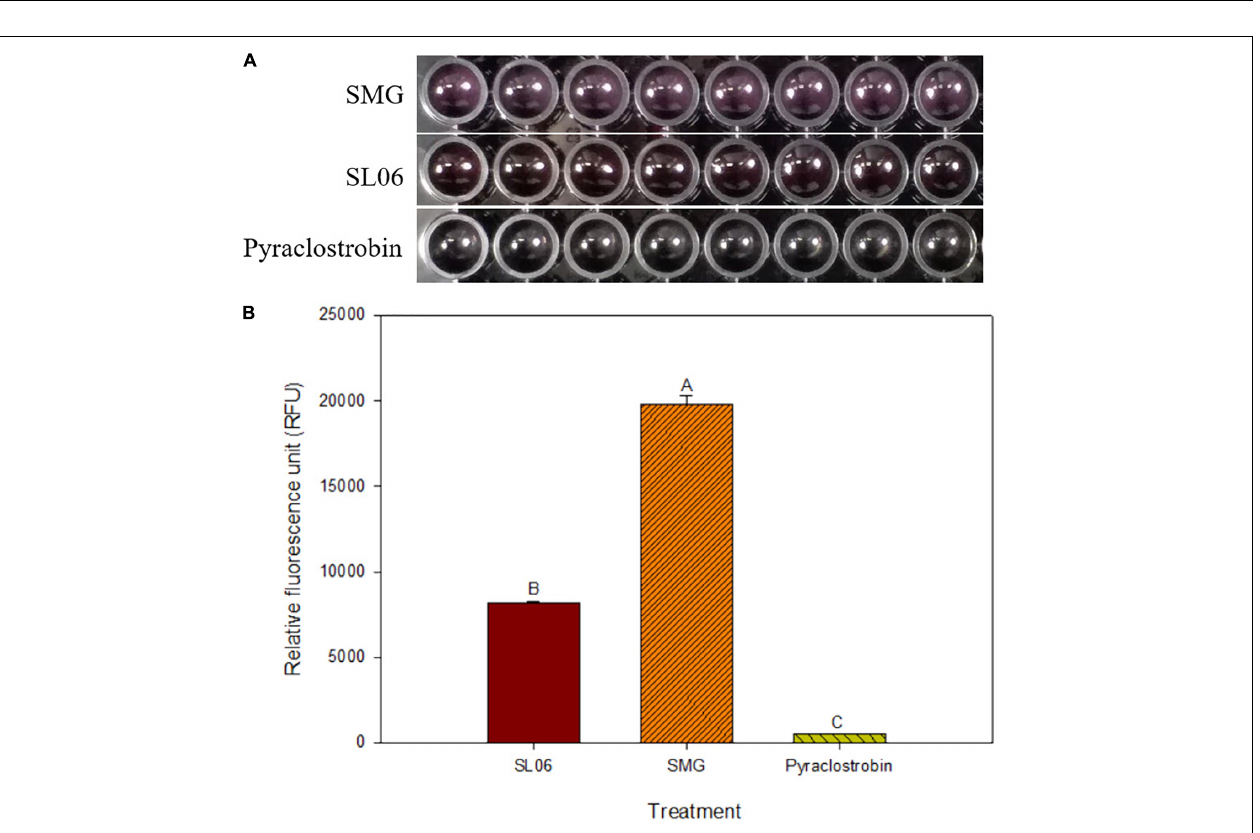
FIGURE 5 | Effect of Streptomyces griseorubiginosus LJS06 culture filtrate (SL06) on membrane integrity and oxidative status of the conidia of Colletotrichum orbiculare . The conidia treated with diluted SL06 were stained with Evans blue, suggesting impaired membrane integrity of the conidia (A) . Additionally, green fluorescence was observed in SL06-treated conidia, suggesting reactive oxygen species accumulation in the conidia (B,C) . By contrast, SMG broth-treated conidia was not stained with Evans blue (D) , and no fluorescence was observed, suggesting intact cell membrane and normal oxidative status in the conidia (E,F) . Bar = 10 µ m.